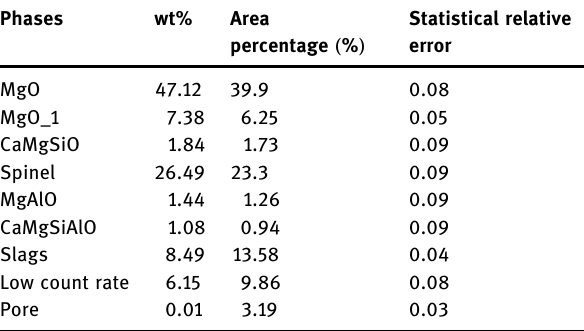
Table 10: Statistical results of MgO · Al 2 O 3 mineral phase